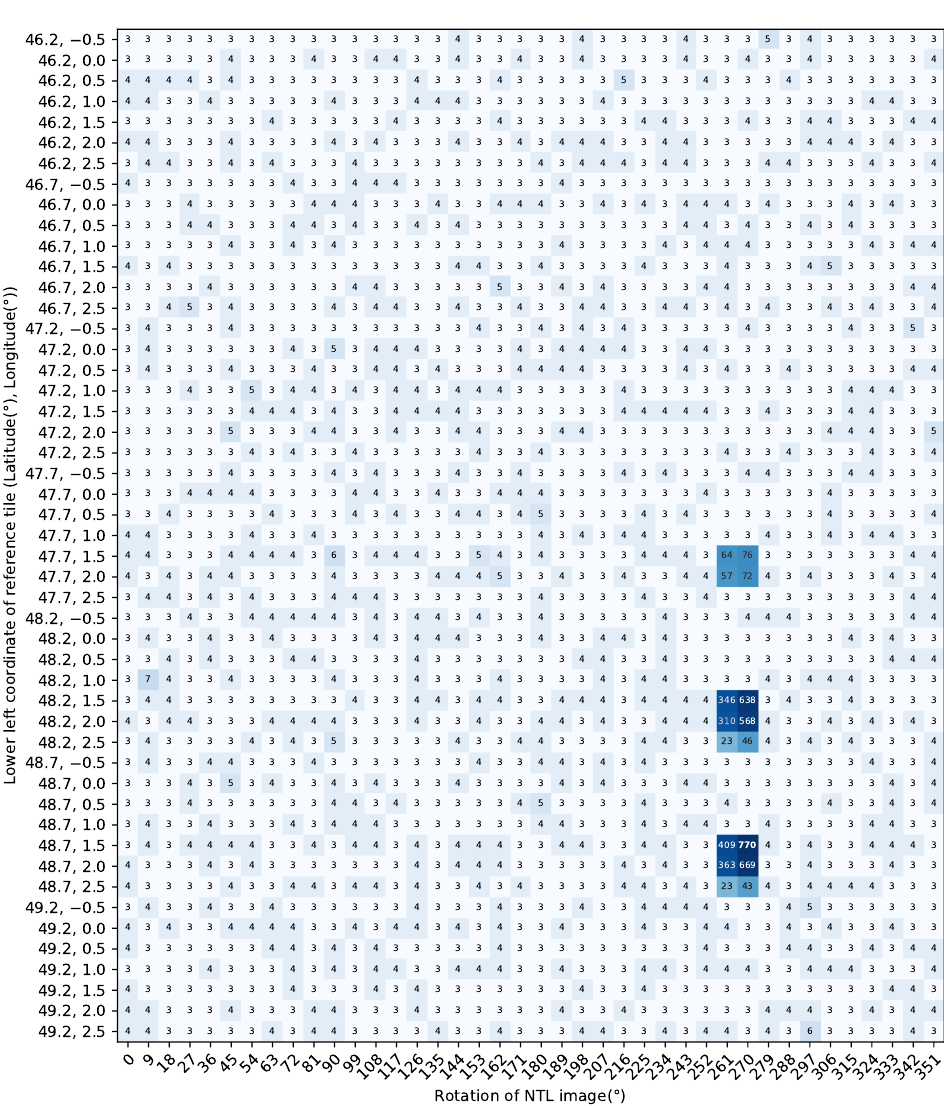
Figure 5. Total of 770 filtered matches obtained for Paris. The reference image generated from OSM is shown on the left, while the NTL image is shown on the right.